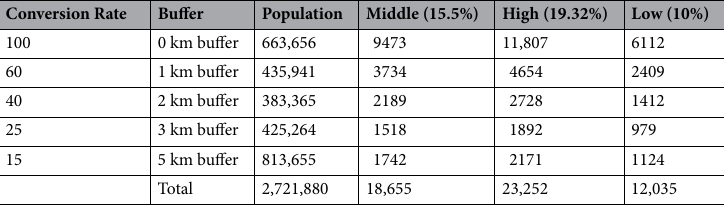
Table 3. Total estimated plastic input into Tonle Sap Basin in